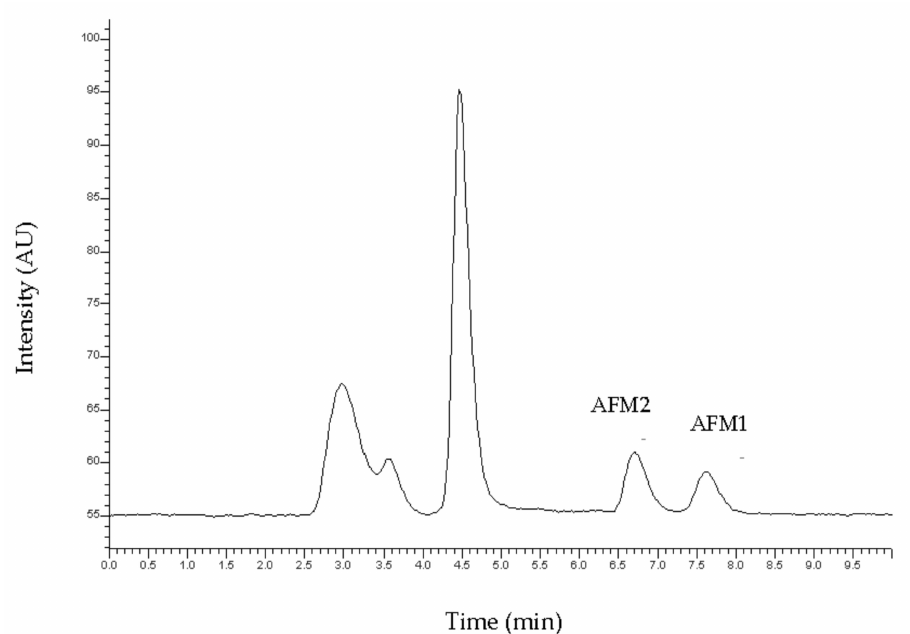
Figure 1. Typical chromatogram of the standard solution of Aflatoxin M1 (AFM1) and Aflatoxin M2 (AFM2) at the concentration of 50 ng kg − 1